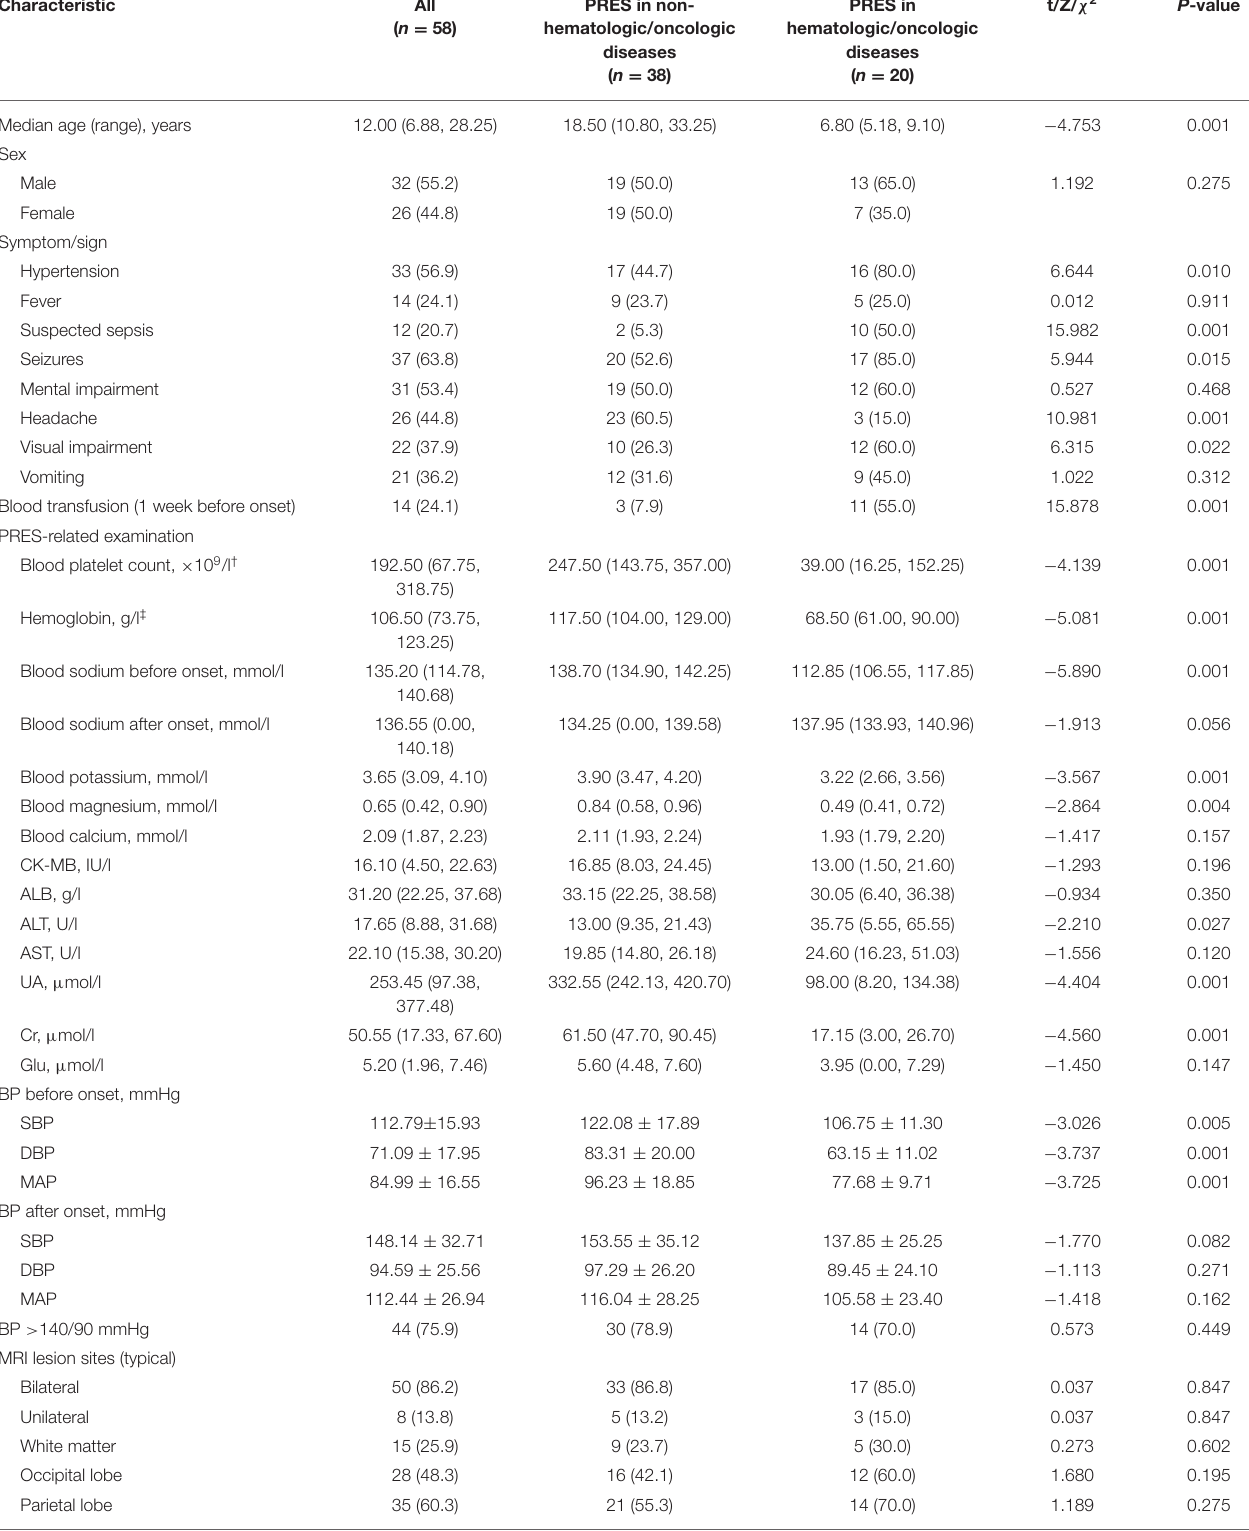
TABLE 1 | Clinical and epidemiologic characteristics of patients with PRES in oncologic/hematologic diseases or non-oncologic/hematologic diseases. Characteristic All